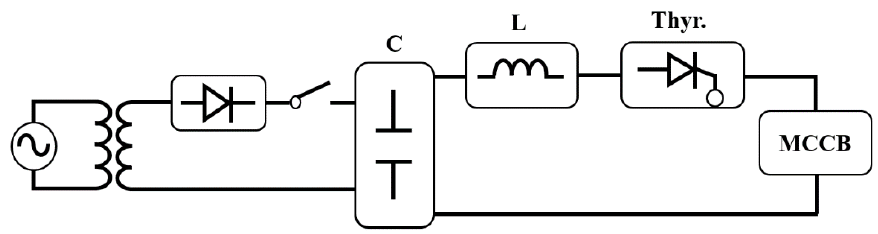
Figure 14. Experimental setup for MCCB interruption phenomena analysis.